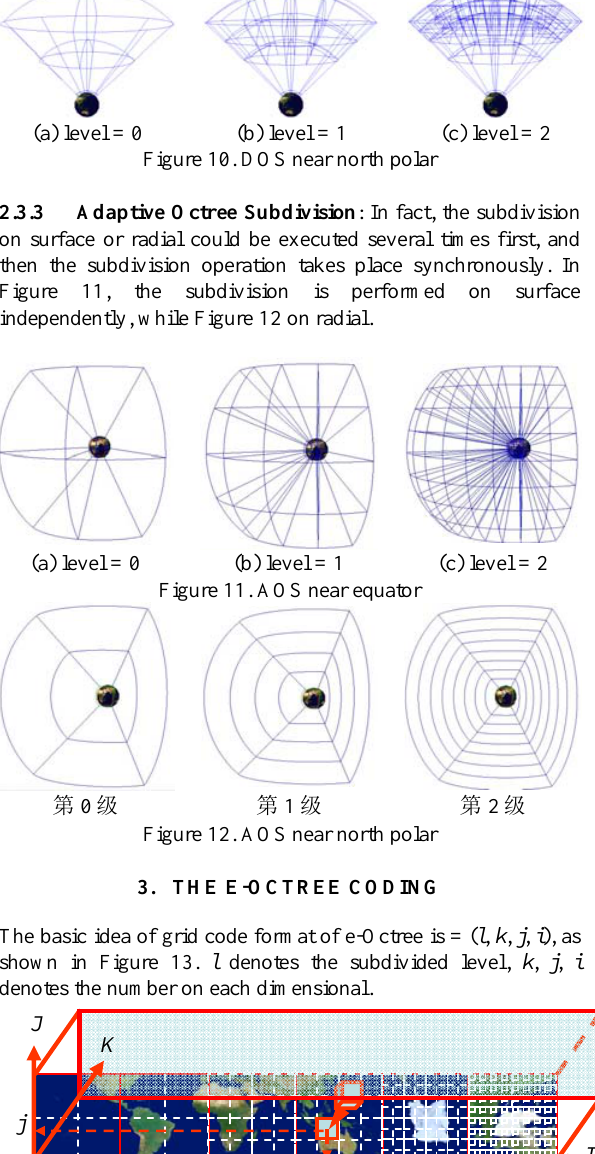
Figure 9. DOS near equator